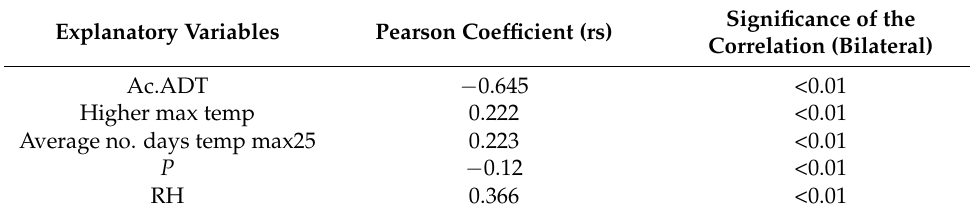
Table 7. Correlation between the dependent variable and some explanatory variables (coefficient of Pearson).